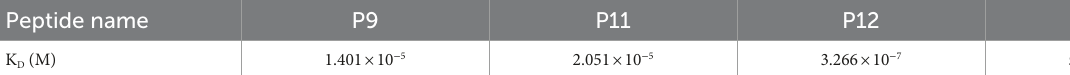
TABLE 3 Kinetic parameters of the interaction between peptides and A β 1–42 .